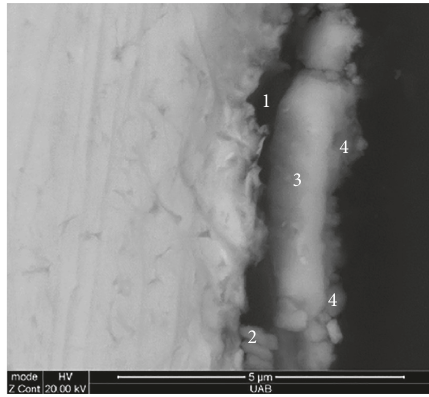
Figure 16: SEM image of cross section of the B-123 (YSZ) sample. Table 3: The elemental analysis (EDS spot) for the different phases (marked) in Figure 16 (atomic percent). Elements